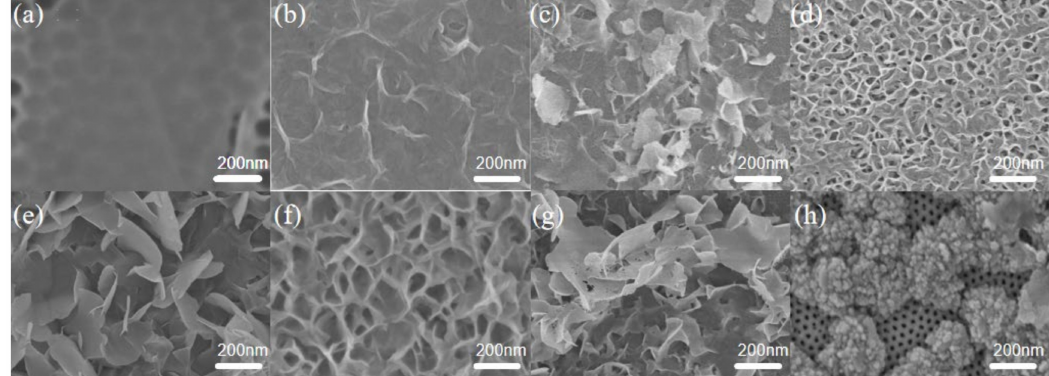
Figure 6. SEM images of nano-PAA-CuCl 2 composite, CuCl 2 nanoflakes grown on the top surface of nano-PAA substrates with different initial concentrations of CuCl 2 solution. ( a ) 1 × 10 − 4 mol/L, ( b ) 2 × 10 − 4 mol/L, ( c ) 3.5 × 10 − 4